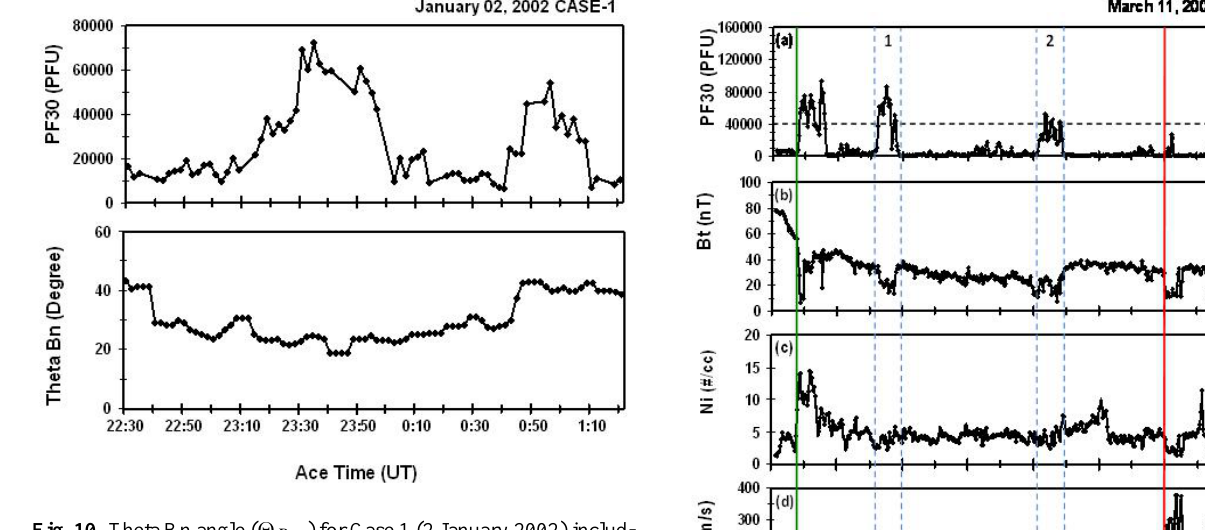
Fig. 10. Theta Bn angle ( 2 Bn ) for Case 1 (2 January 2002) includ- ing intervals for Bursts 1 and 2.